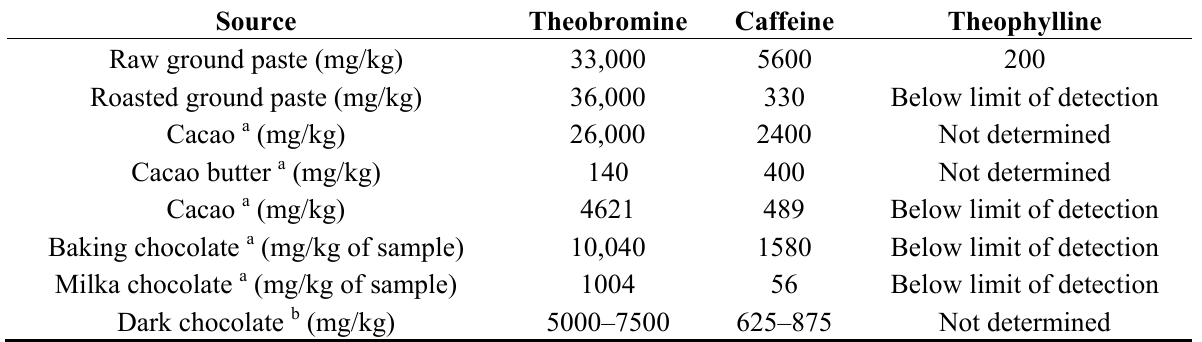
Table 1. Methylxanthine content in different cacao sources and